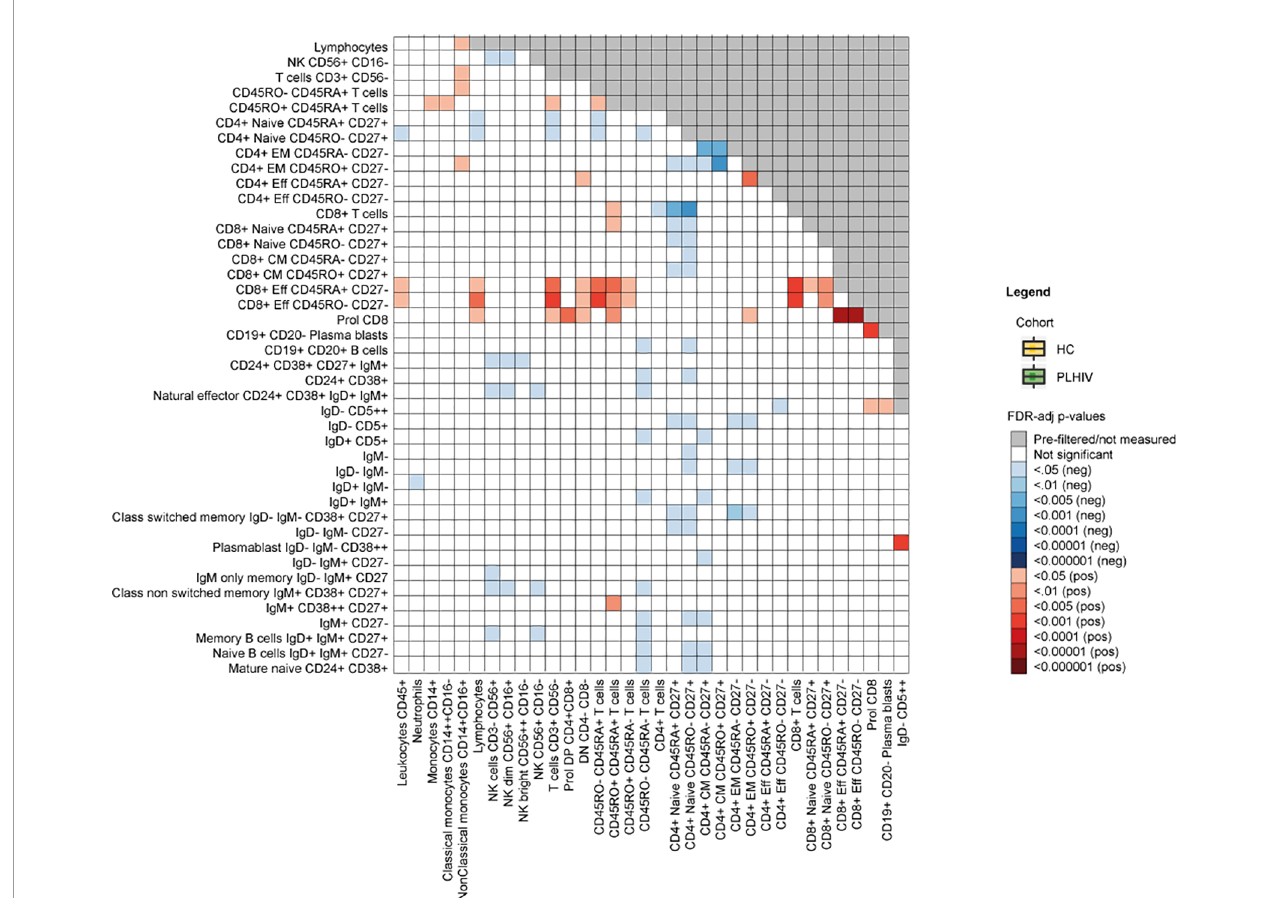
FIGURE 2 | Differences in cell-cell associations between PLHIV and healthy individuals. Exploratory analysis depicting cell-cell associations between a total of 77 available WBC subsets that were signi fi cantly stronger (red) or weaker (blue) in PLHIV compared to healthy controls (n=534). FDR-adjusted p-values are obtained after 10 000 permutations and adjusted for age, sex, sampling time and season. HC, healthy control; PLHIV, people living with HIV; WBC, white blood